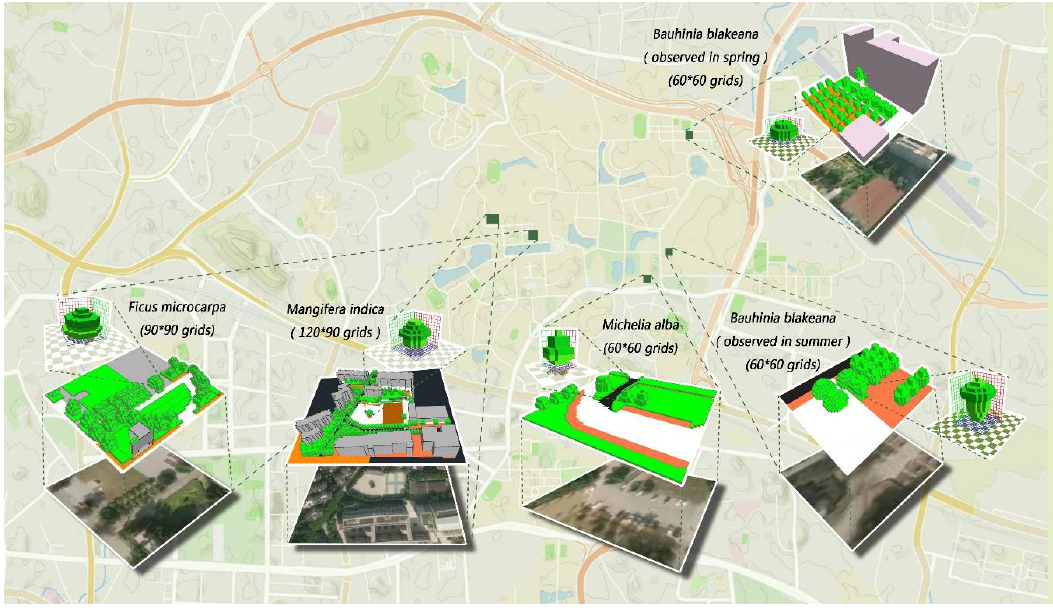
Figure 3. Study areas and their models.